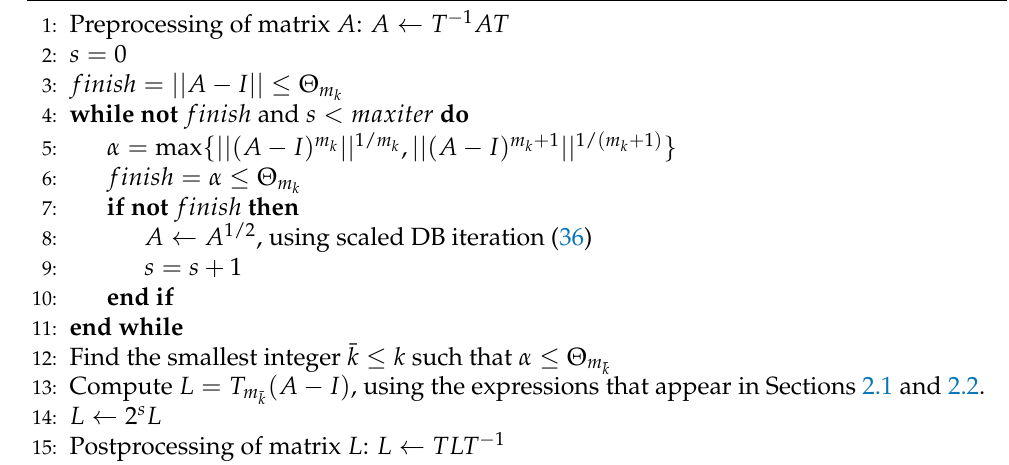
Algorithm 1 Given a matrix A ∈ C n × n , a maximum approximation order m k , k ∈ { 1, 2, 3, · · · , 13 } , and a maximum number of iterations maxiter , this algorithm com- putes L = log ( A ) by a Taylor approximation of order lower that or equal to m k